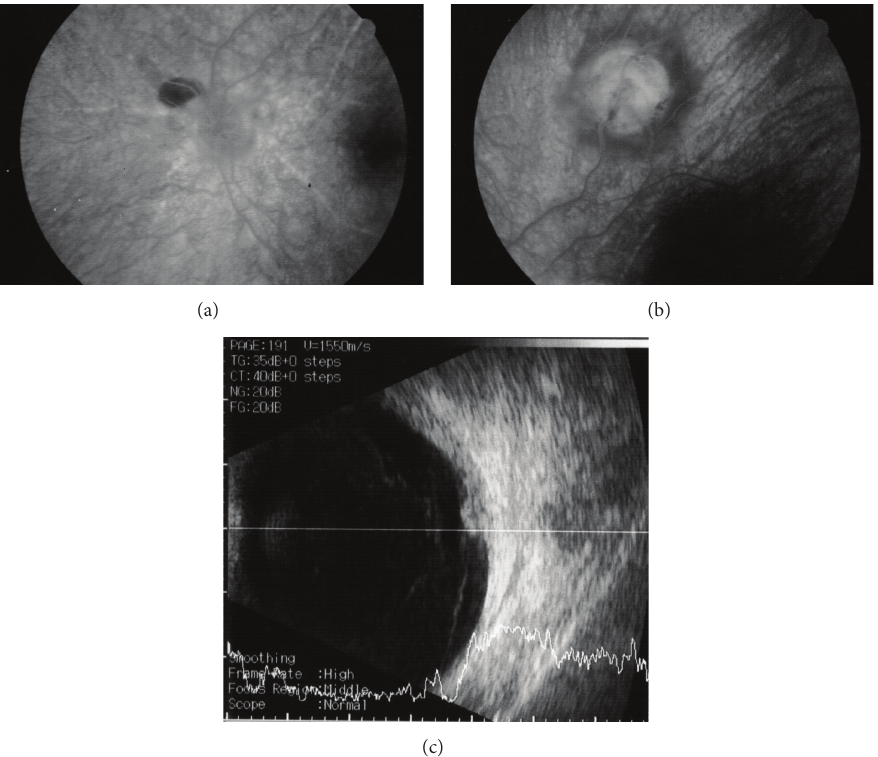
Figure 2: (a-b) Fluorescein angiography (FA) demonstrated background hyperfluorescence corresponding to the “sunset glow fundus” and hyper- and hypofluorescence of the RPE proliferating lesions. (c) A B-scan ultrasound of the larger peripheral RPE proliferations showed a dome-shaped mass 2mm in height, high internal reflectivity, and a partial posterior vitreous